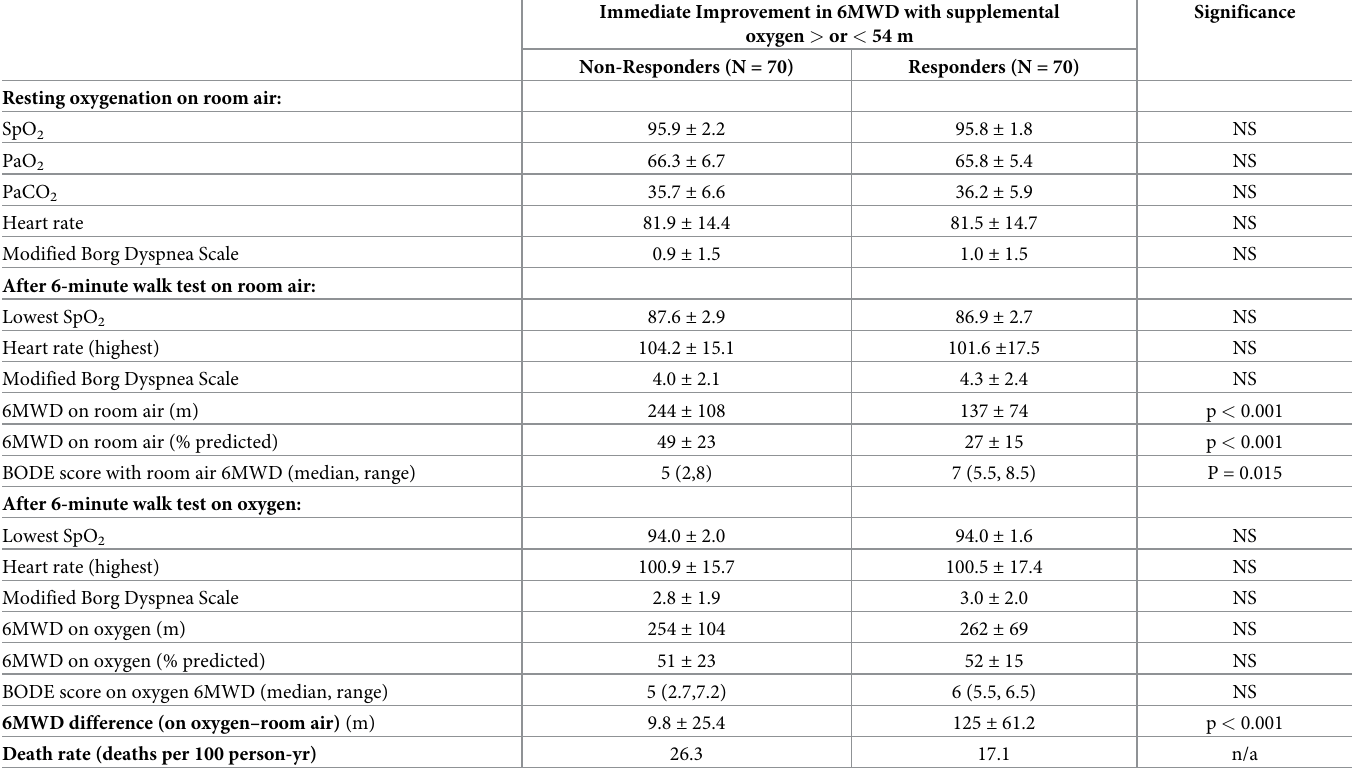
Table 2. Oxygenation and other 6-minute walk testing parameters between responders and